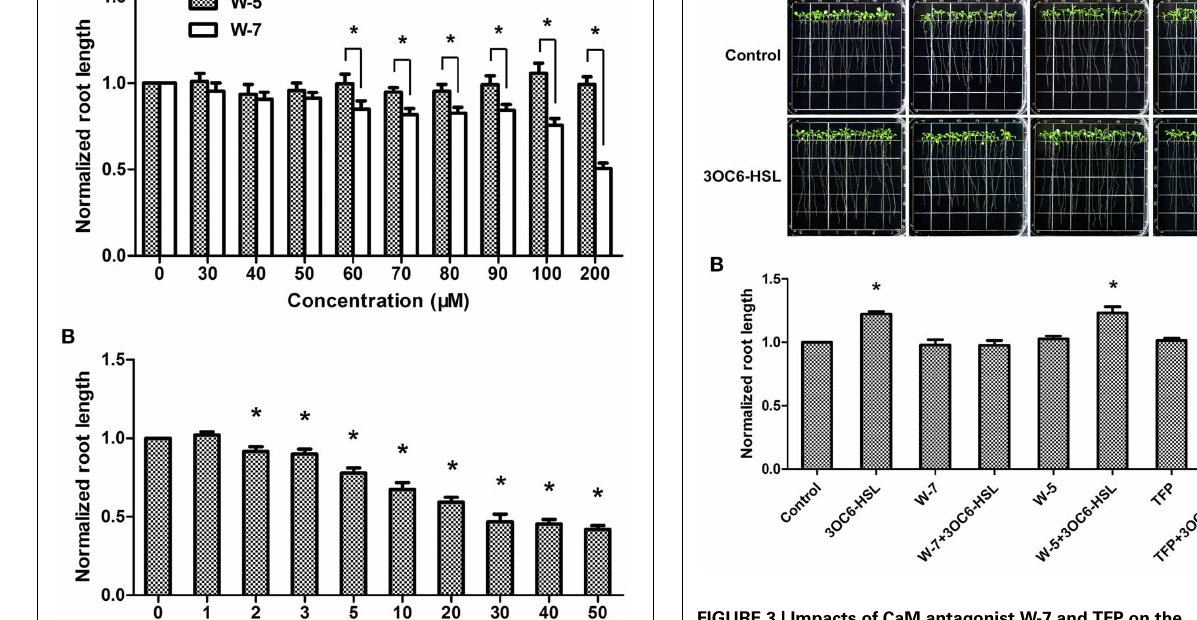
FIGURE 3 | Impacts of CaM antagonist W-7 and TFP on the growth-stimulating effect of 3OC6-HSL for primary root elongation. (A) Images of Arabidopsis seedlings grown on vertically oriented plates containing different combination of 3OC6-HSL plus W-7, W-5 or TFP. (B) Plot of effects of CaM antagonists on primary root length in presence of 3OC6-HSL. Wild-type plants were exposed to 3OC6-HSL and CaM antagonists W-7, W-5 (W-7 dechlorinated analog, no antagonist activity) and TFP for 7 d and evaluated for variations in primary root length. The plants grown on the plates without addition of 3OC6-HSL, W-7, W-5, and TFP were taken as the control. 1 μ M 3OC6-HSL, 50 μ M W-7, 50 μ M W-5, and 1 μ M TFP were applied into media when necessary. The results were normalized to the root lengths of untreated control. Each value is the average of three independent experiments. Each experiment included at least 30 seedlings. Entries with p -values < 0.05 shown with